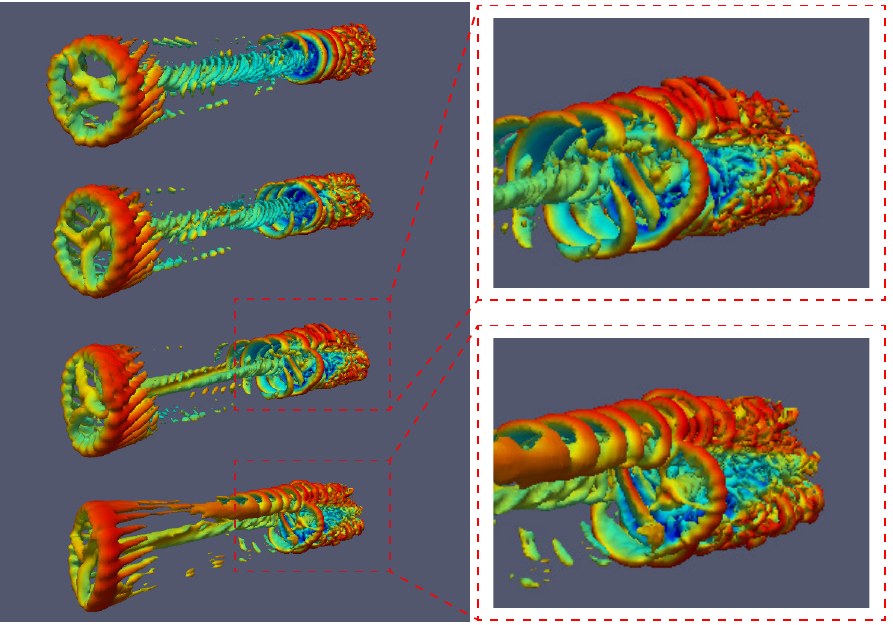
Figure 16. Three-dimensional vortices structure in the vicinity of the turbines with 7D spacing for yaw angle from 0 ◦ to 30 ◦